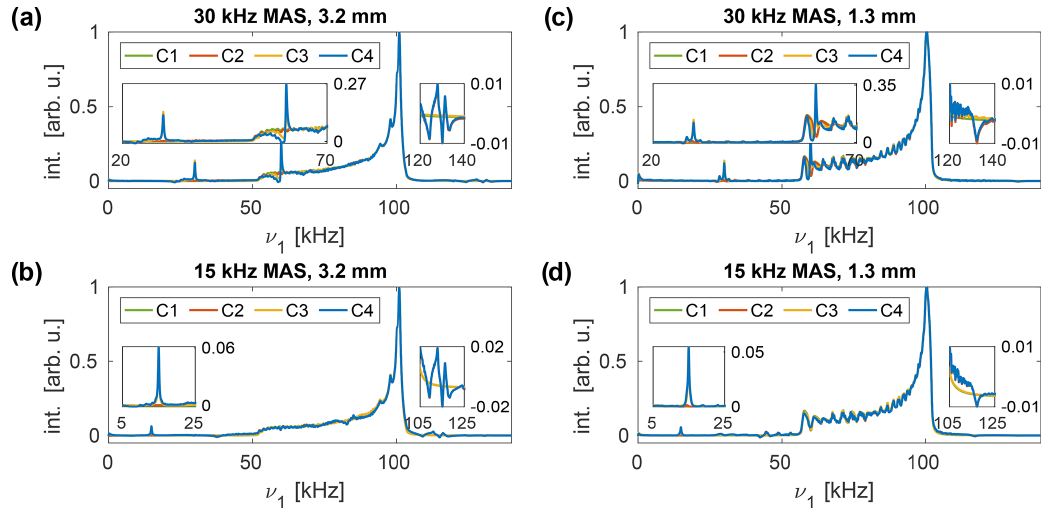
Figure 3. Simulated nutation spectra at a resonance frequency of 600MHz for the 3.2mm MAS probe (a, b) and the 1.3mm MAS probe (c, d) for a nominal rf amplitude of 100kHz. A spinning frequency of 30kHz (a, c) and 15kHz (b, d) was assumed for the spectra. Sidebands at 0 ± m · ν r arise when rf phase modulations are taken into account (C3 and C4), while those at ν 1 ± m · ν r occur if amplitude modulations are present (C2 and C4). The amplitude modulation sidebands increase in intensity at lower MAS frequencies, whereas the phase modulation sidebands are attenuated. Both sideband families are less intense in the 1.3mm probe, and the overall nutation profile is narrower, indicating an improved homogeneity of the rf distribution inside the coil.